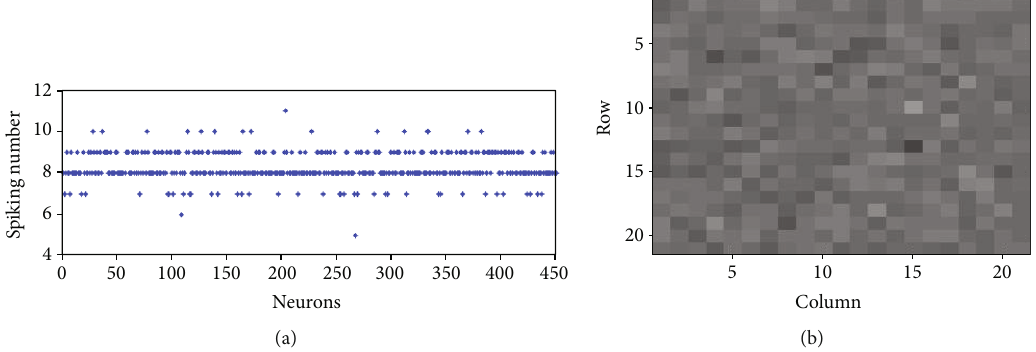
Figure 4: Firing rates of all excitatory neurons of a population of isolated excitatory neurons with no noise, σ S excitatory neurons within 300ms; (b) visualization of the fi ring rates of neurons 1-400.